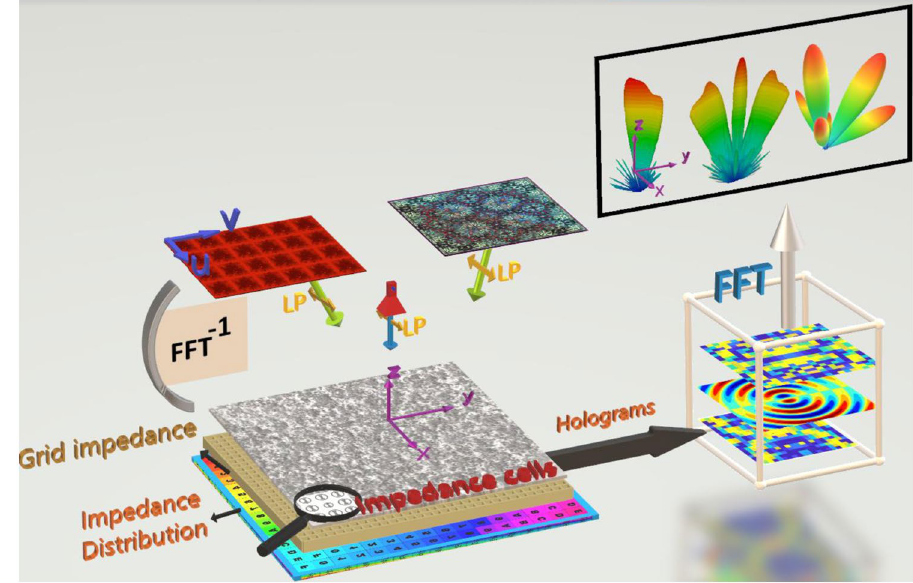
Figure 1. The conceptual demonstration of the holographic-based method for shaping the EM waves.